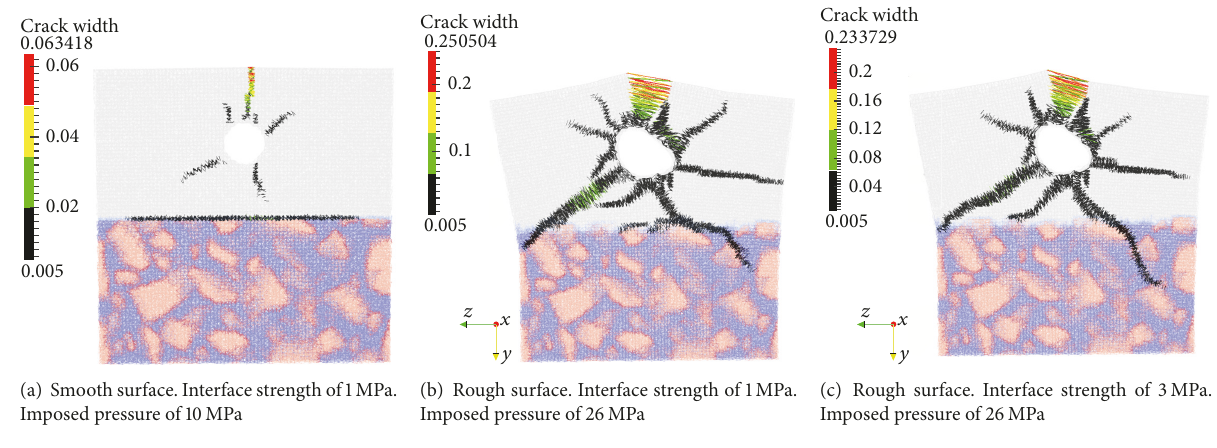
Figure 12: Numerically obtained crack pattern and maximum crack widths [mm] due to the pressure imposed by expanding the bar in repair systems. Mortar is used as a repair material, influence of the substrate surface roughness, and the interface strength; top: repair material; bottom: substrate (deformation scaled 20x; note that for different samples maximum crack widths are different).